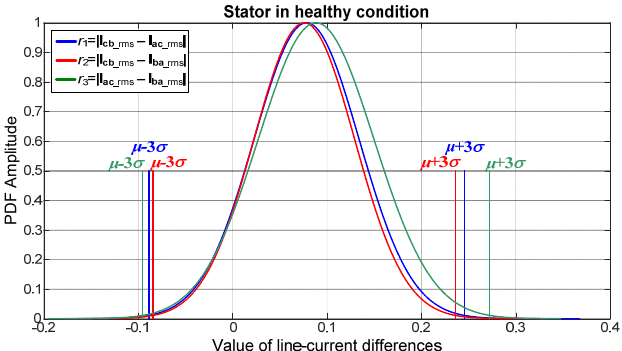
Figure 13. Probability density functions (PDF) for the arithmetic differences r 1 , r 2 , and r 3 from a healthy motor.